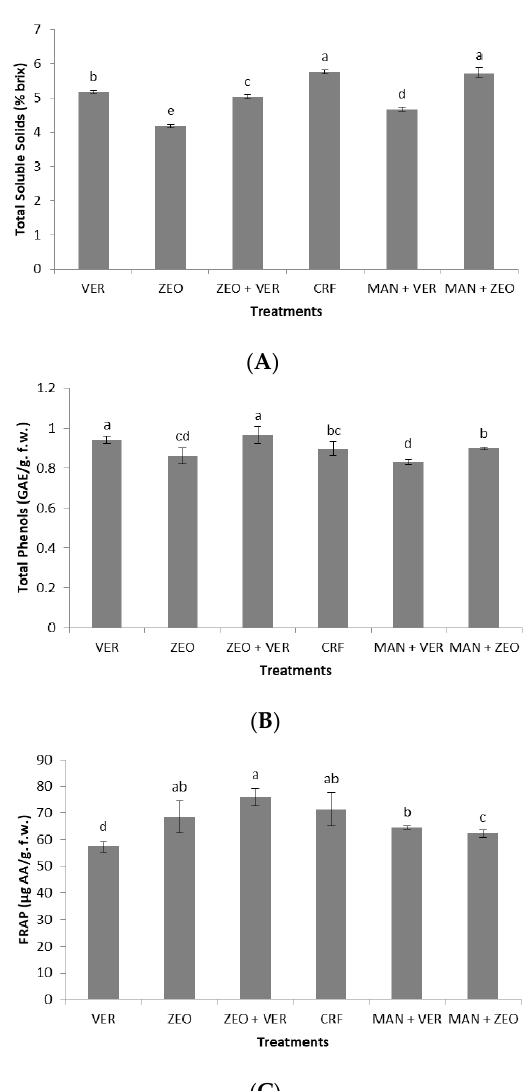
Figure 5. Total soluble solids ( A ), total phenols ( B ) and antioxidant activity (FRAP) ( C ) of pepper plants among the treatments. The different letters on the bars signify statistically significant differences among the treatments, according to Duncan’s multiple range test, for p ≤ 0.05. VER: vermiculite; ZEO: zeolite; CRF: controlled-release fertilizer; MAN: manure.